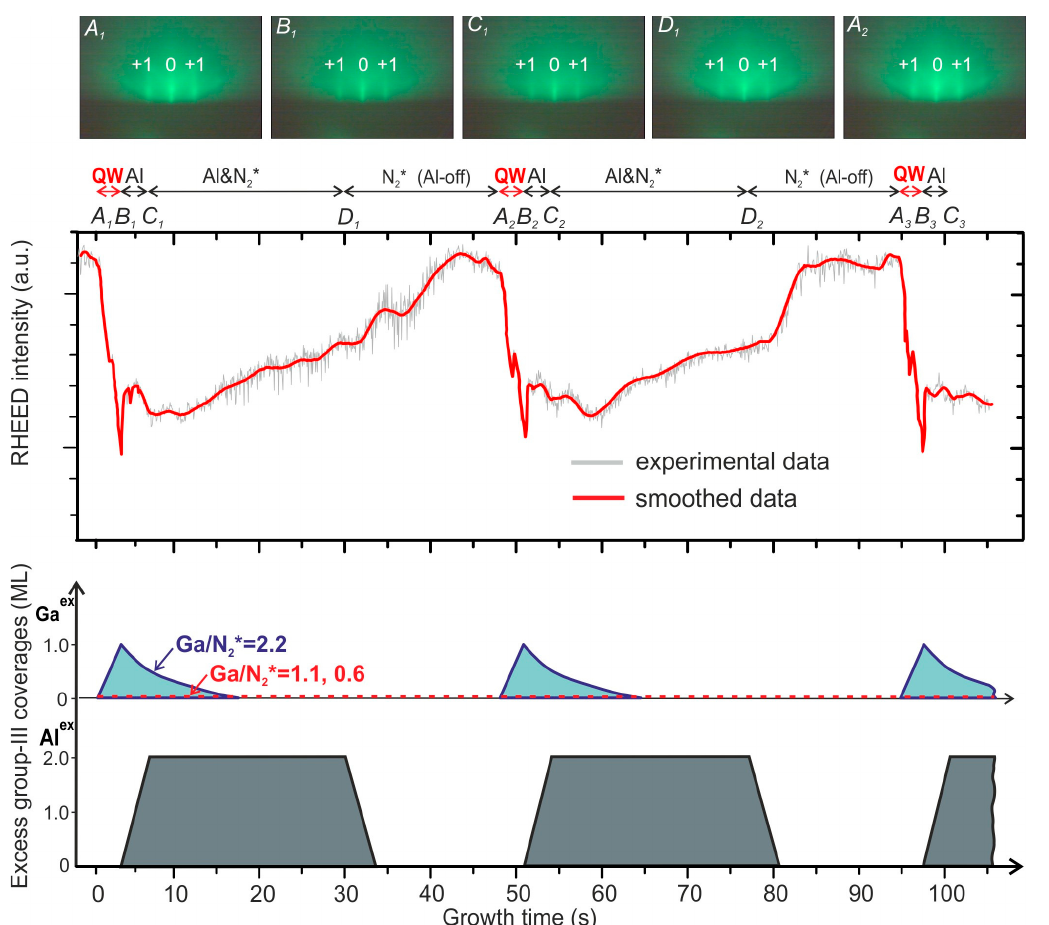
Figure 2. Time variation in the intensity of RHEED specular reflex (denoted in the photographs by the number 0) during the growth of two periods of 400 × {GaN 1.5 /AlN 16 } MQW structures under Ga-rich conditions (Q1.5-2.2-S). The upper insets show RHEED patterns recorded at different characteristic temporal points: A i , B i , C i , D i ( i = 1, 2). The lower insets show time diagrams illustrating the accumulation of excess Ga(Ga ex ) and Al (Al ex ) atoms during the growth of MQW structures with QWs grown at various Ga/N 2 * flux ratios. When plotting these diagrams, the Ga desorption rate was equal to 0.3 ML · s − 1 and the desorption of Al was negligible.